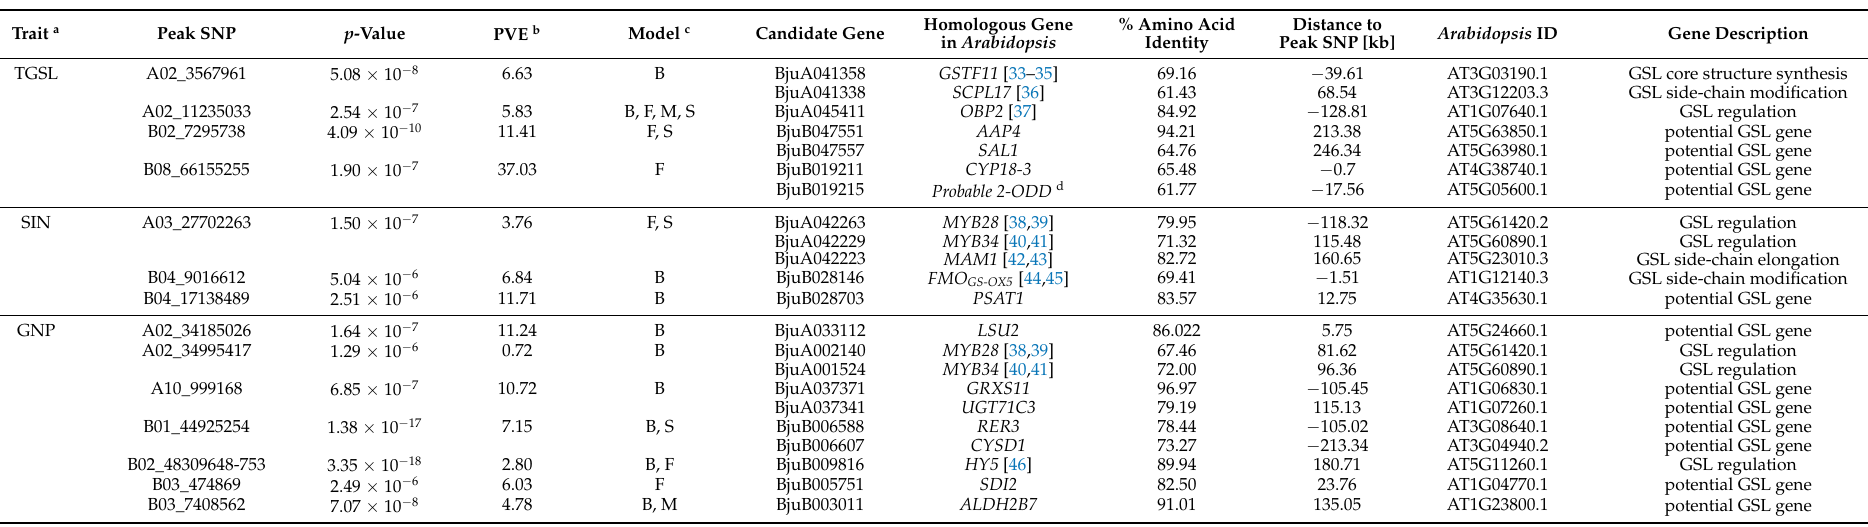
Table 1. Peak SNP characteristics and respective candidate genes homologous to known and potential Arabidopsis genes involved in GSL